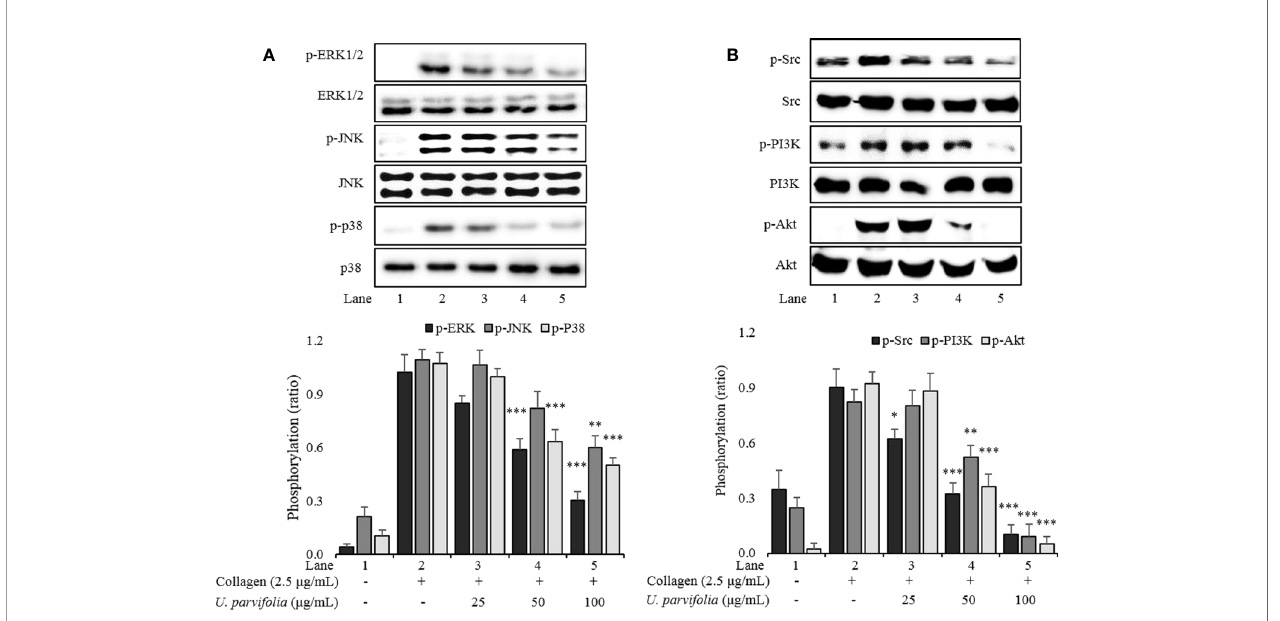
FIGURE 4 | U. parvifolia attenuates phosphorylation levels of MAPKs (A) , Src, and PI3K/Akt (B) . Immunoblotting was conducted to analyze the phosphorylation of signaling molecules extracted from the lysates of collagen-stimulated washed platelets that were pre-treated with either U. parvifolia extract or vehicle. Representative immunoblot images and data (mean ± SD) from at least four independent experiments are shown. * p < 0.05, ** p < 0.01, and *** p < 0.001 versus agonist-treated group.